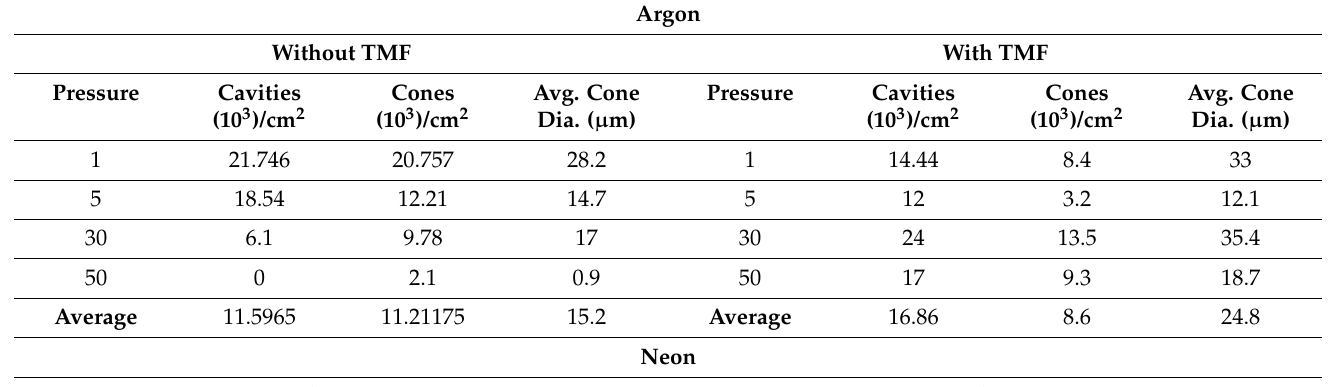
Table 5. Averaged cavities and cone densities and their averaged diameter at different pressures of Ar, Ne, and He in the presence and absence of TMF.